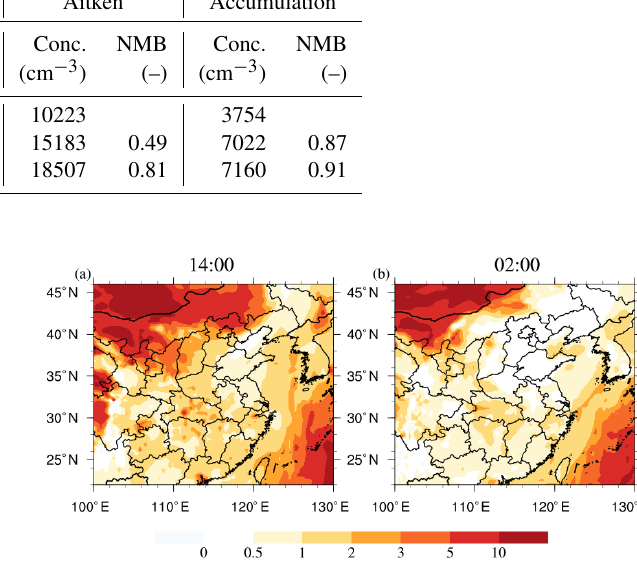
Figure 11. Difference in sulfate/BC on 1 July (a) 14:00 and (b) 02:00CST between SG and F0 at the surface. The difference is calculated as the simulation of SG minus